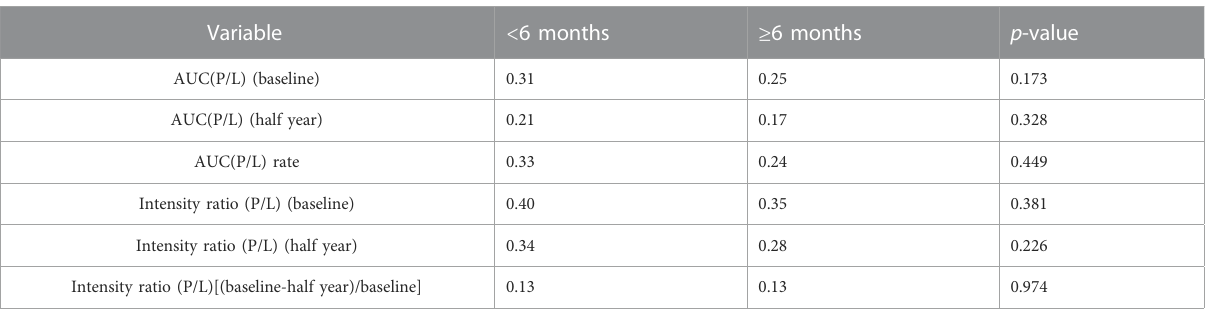
TABLE 4 Subgroup analysis based on statin